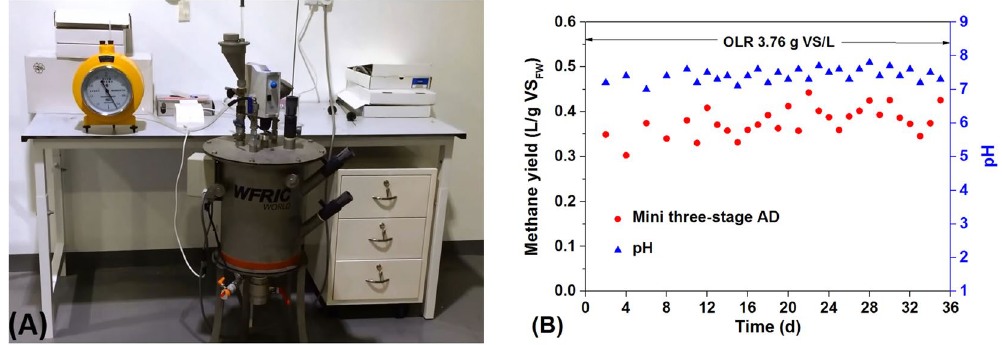
Figure 6. ( A ) A 20 L mini three-stage anaerobic digester system; ( B ) Methane yield and